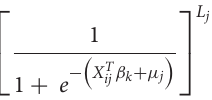
or non-management at the interface of PL and NL